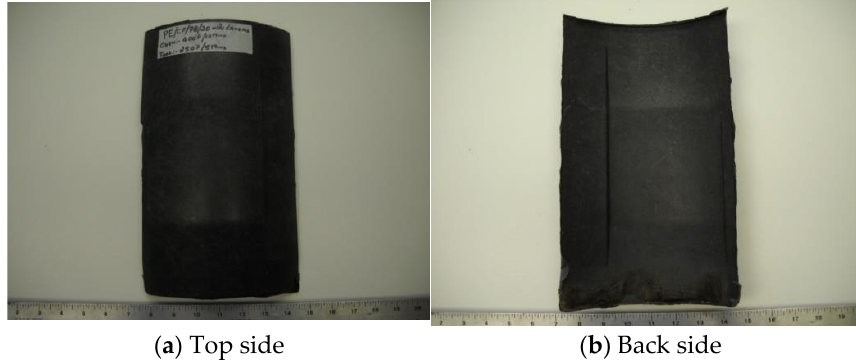
Figure 12. Forming of shell shape through external heating and compression molding.